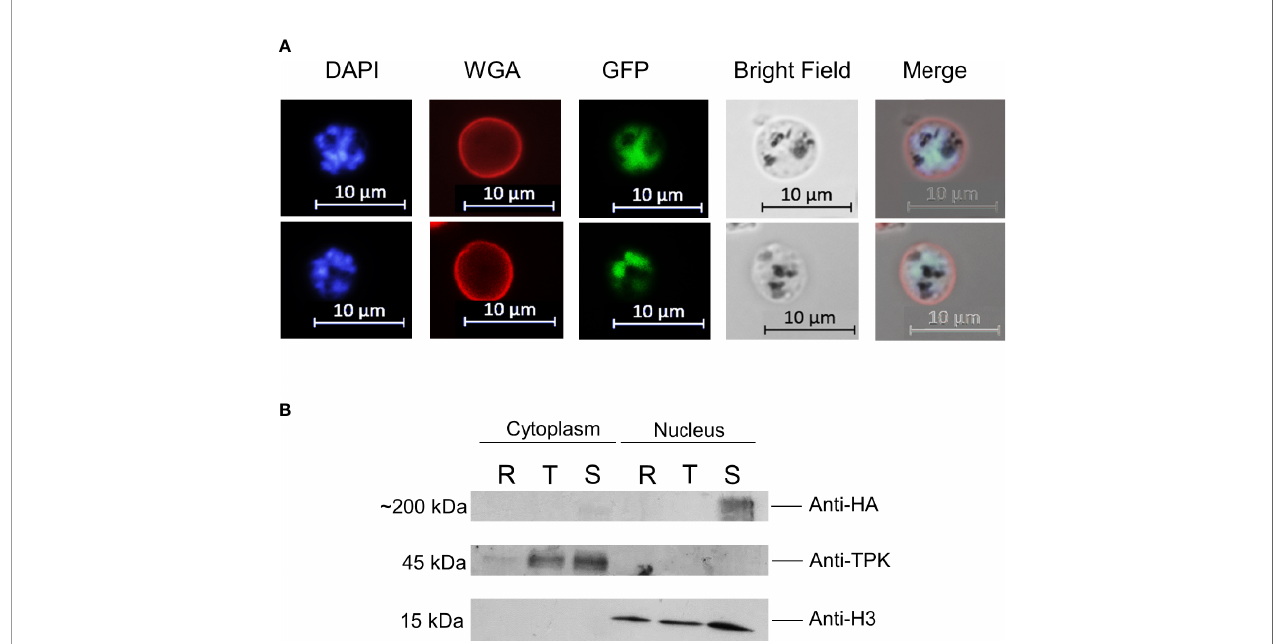
FIGURE 2 | PfAP2-O-GFP-HA-DD24 is expressed in schizont stage parasites. (A) Fluorescence microscopy of late schizont parasites shows that GFP-tagged PfAP2-O colocalizes with the DAPI (nuclear stain) signal. WGA marks the surface of red blood cells. (B) Western blot of cytoplasmic and nuclear fractions obtained from PfAP2-O-GFP-HA-DD24 expressing parasites shows that AP2-O-GFP-HA-DD24 is found exclusively in the nucleus of schizonts. The membrane containing the transferred proteins was cut in three parts and was probed with monoclonal anti-HA (upper part), polyclonal anti-TPK (middle part), and monoclonal anti-Histone 3 antibodies (lower part). See Supplementary Figures for the full-size